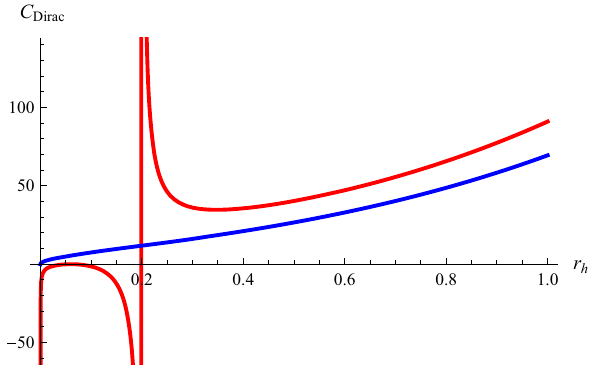
Fig. 1 C Scalar - r h curve. The blue and red lines are correspond to the standard and the modified heat capacities of the spinning dilaton black hole, respectively. We set Λ = 1 ,α = 10 − 2 , j = 3 , ¯ h = J = m = 1